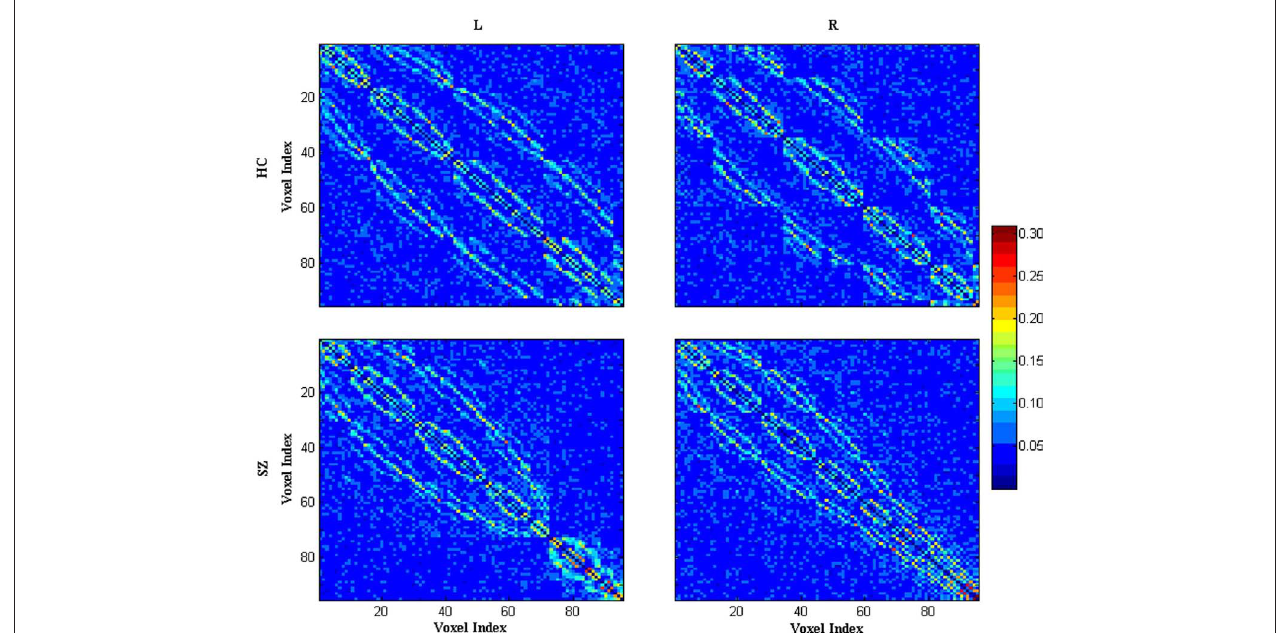
3D spatial organization of 95 voxels were transformed into 1D alignment organized by slice ( z -coordinate). The diagonal running from the upper left to the lower right is intentionally set to zero (L: the left task-related network; R: the right task-related